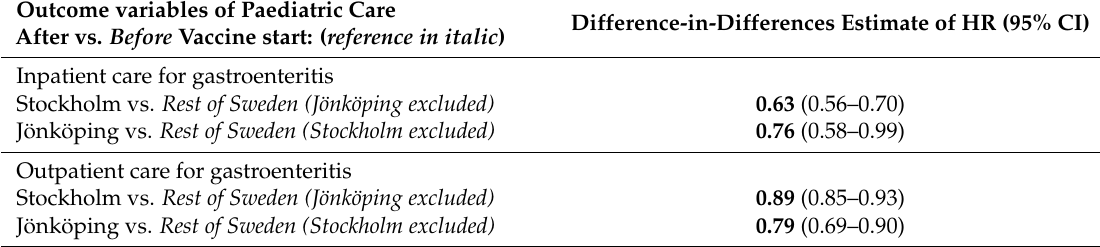
Figure 2. Incidence (incidence cases/10,000 persons) of paediatric outpatient care of viral gastroenteritis in Swedish children aged 12–24 months during 2011–2016. Table 2. Adjusted hazard ratios (HRs) of paediatric inpatient and outpatient care of viral gastroenteritis. Adjusted for parental education, maternal age, social welfare, having two foreign-born parents, and single-parent household